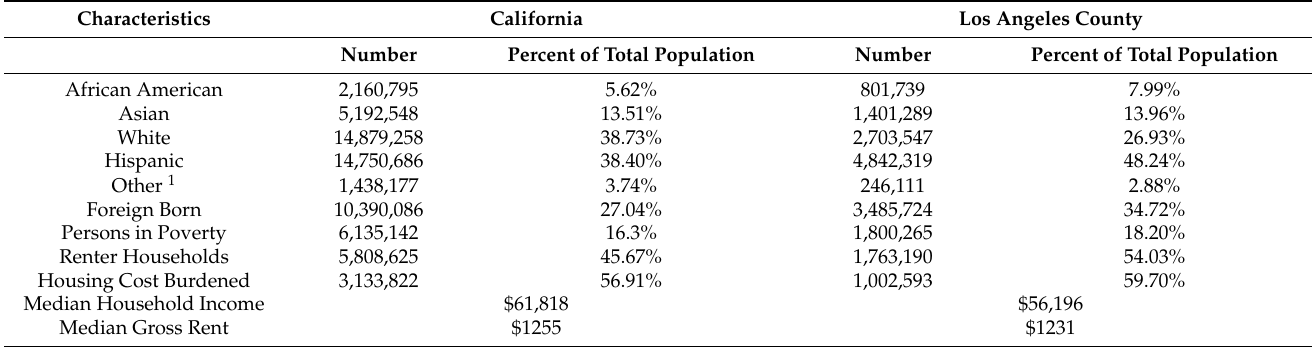
Table 2. Population and Housing Characteristics, CA and LA County,